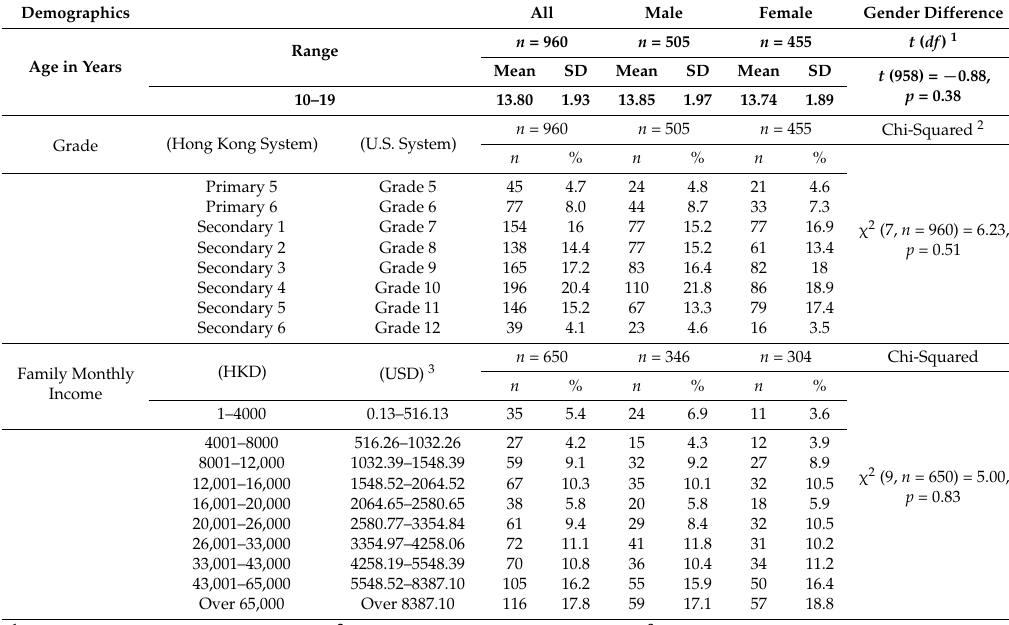
Table 1. Demographic characteristics including age, grades and family monthly income, and their gender